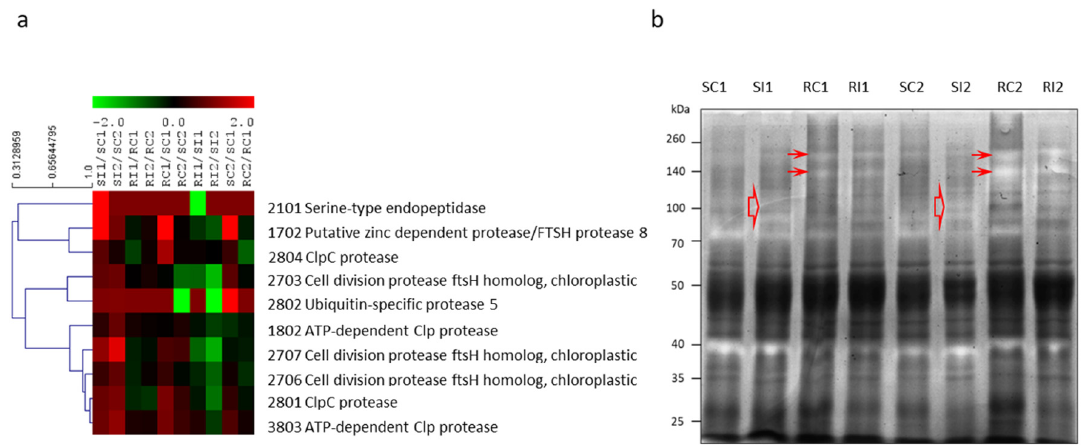
Figure 4. ( a ) Hierarchical clustering of proteases identified by MALDI-TOF analysis based on protein abundance as determined by 2DE. Susceptible genotype (S) and resistant genotype (R); control (C) and B. fabae inoculated (I); 6 hpi (1) and 12 hpi (2). ( b ) Zymogram of proteases in faba leaves separated by SDS-PAGE bearing gelatin under nondenaturing conditions. Arrowheads denote differential bands between genotypes or treatments.